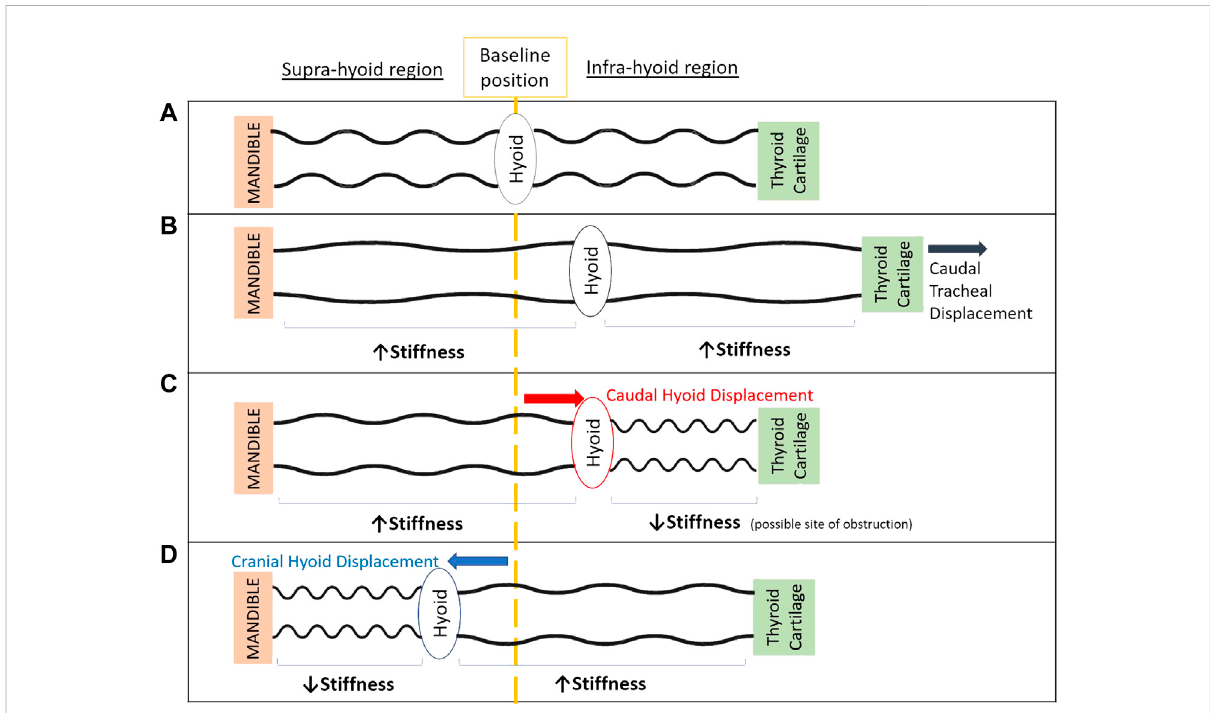
FIGURE 5 Schematic model of the upper airway demonstrating the potential effect of cranial and caudal hyoid repositioning on supra-hyoid and infra- hyoid upper airway regions to aide in explaining study outcomes. When the hyoid is at its baseline position (A) , the upper airway is patent. Displacementofthethyroidcartilageandhyoidcaudallywithcaudaltrachealdisplacement (B) ,stretchesupperairwaysofttissuesinbothsupra-and infra-hyoidregions,hencestiffeningtheairway ’ swallsalongitslength(Amatouryetal.,2014;Amatouryetal.,2016;Tongetal.,2019).Unfolding of the upper airway wall may also occur (Amatoury et al., 2010; Kairaitis et al., 2015). Following direct application of caudal hyoid bone displacement (C) , supra-hyoid tissues are stretched, however infra-hyoid tissue (e.g., thyrohyoid, sternohyoid and omohyoid muscles) strains are likely reduced (unlike with tracheal displacement), leading to a “ fl oppier ” and more collapsible airway segment in this region. The balance between regions along the length the upper airway of increased and decreased stiffness, overall gives way to no change in upper airway collapsibility. Following cranial displacement of the hyoid bone (D) , the soft tissues in the supra-hyoid region (e.g., hyoglossus, styloglossus, palatoglossus) become “ fl oppier ” and the airway narrowed, while the infrahyoid region is stretch and stiffened. Similar to caudal hyoid displacement, this likely results in the overall zero change in upper airway collapsibility with cranial hyoid